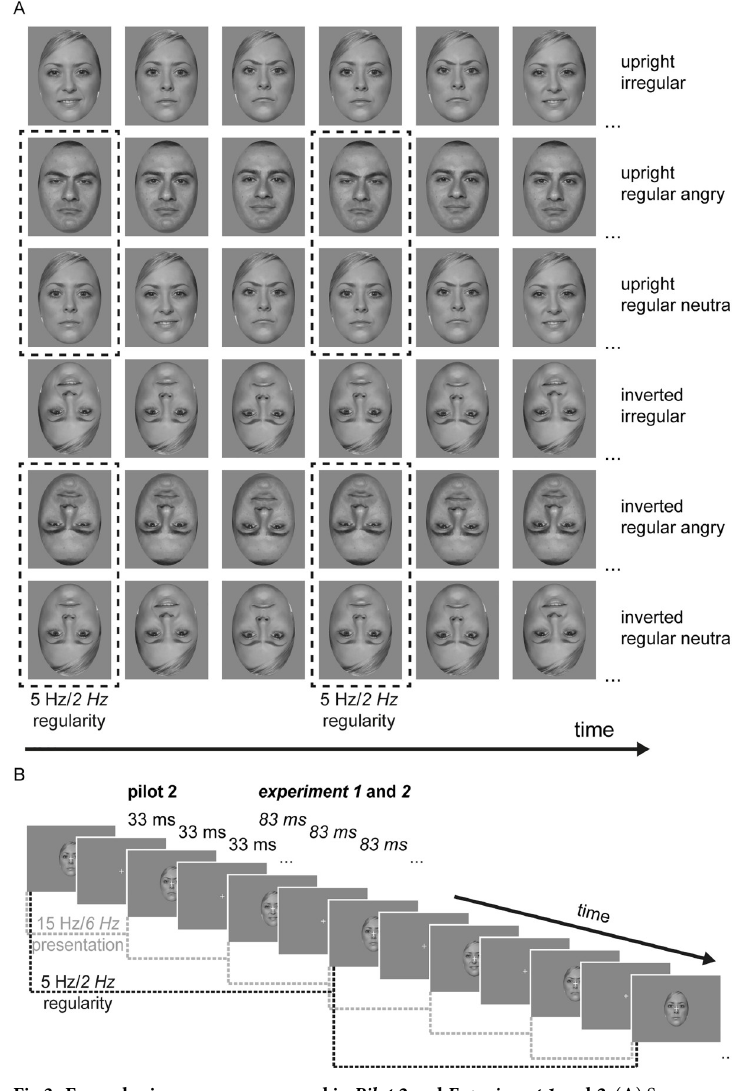
Fig 3. Exemplar image sequences used in Pilot 2 and Experiment 1 and 2 . ( A ) Sequence of six exemplar images for each experimental condition. For the regular conditions, every third image contained a repetition of the same emotional category (angry or neutral). For the irregular condition, image triplets contained all four emotional categories (neutral, angry, happy, disgusted) in random order. Images were presented either upright or upside down. For each trial only one of two face identities was presented, either with low (see top row) or high (see row two) dissimilarity between emotional expressions. Note that, for illustration purposes, we here show images from the Face Research Lab London Set [31], additionally modified in GIMP 2.10.14 (https://www.gimp.org/) to display anger. A set of different (only male) face identities was presented during the experiment, but cannot be shown here due to copyright restrictions. Please refer to https://www.macbrain.org/resources.htm for examples of faces used in the experiment. ( B ) Exemplar visual presentation of stimuli within each trial. Single images were presented for 33 msec in Pilot 2 or 83 msec in Experiment 1 and 2 , followed by a fixation cross-only image of similar duration, leading to a presentation rate of 15 Hz for the image stream in Pilot 2 and 6 Hz in Experiment 1 and 2 . The resulting regularity frequency was 5 Hz for Pilot 2 and 2 Hz for Experiment 1 and 2 during the regular conditions. Note: image not to scale. Stimuli. From the NimStim database [29], we used identities #06 (female, low dissimilar- ity between emotional expressions) and #37 (male, high dissimilarity between emotional expressions). The selected expressions were neutral, angry, happy, and disgusted (all with closed mouth). Emotion dissimilarity was determined by calculating the structural similarity